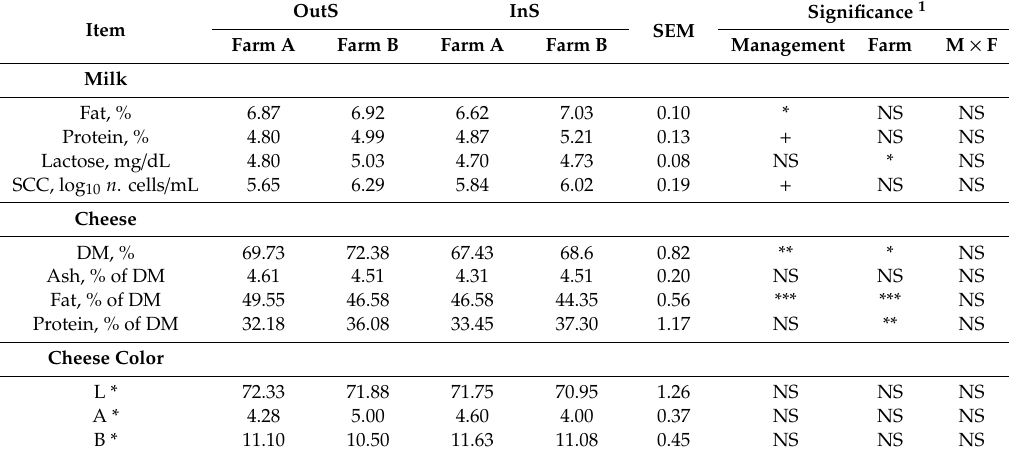
Table 4. Milk and cheese chemical composition and color characteristics of cheese (LSM ± SEM) as a ff ected by the management system, farms, and their interaction. OutS InS Item